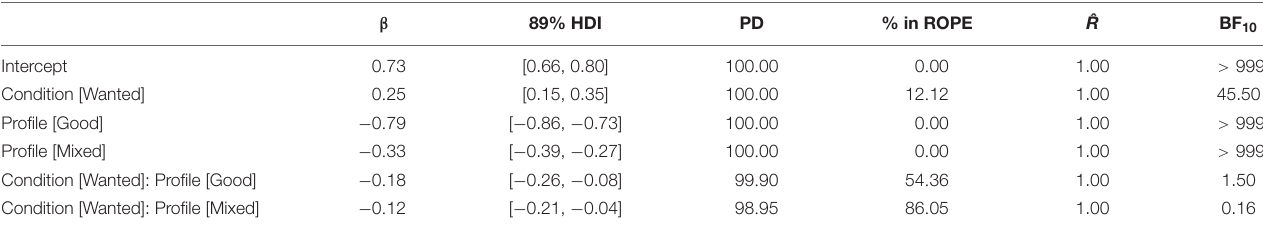
FIGURE 9 | The probabilities of deciding to rent a room between the two experimental conditions (Wanted and Avoided) split over the three Profile conditions (Bad, Mixed, and Good). Error bars indicate 95% credible intervals. TABLE 10 | Summary of the model fitted to the accuracy data, considering the experimental condition (Wanted or Avoided) and Profile type (Good, Mixed, and